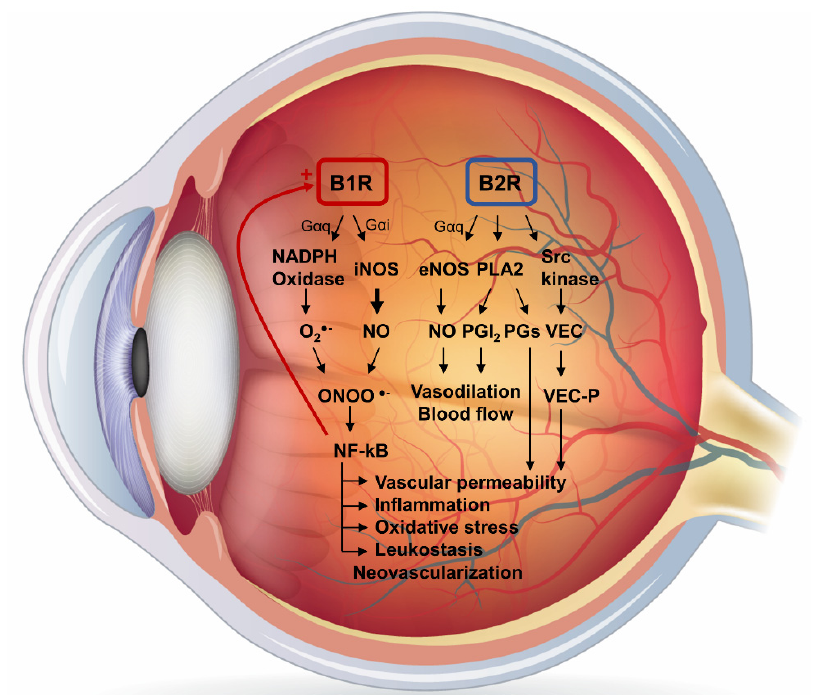
Figure 2. Kallikrein–kinin system in diabetic retinopathy. Schematic proposal of the signaling path- ways activated by B1R and B2R in diabetic retinopathy. PGs, prostaglandins; PGI2, prostacyclin; PLA2, phospholipase A2; Src, kinase proto-oncogene tyrosine-protein kinase; VEC, vascular endo- thelial cadherin; VEC-P, phosphorylated vascular endothelial cadherin. The human eye anatomy diagram was acquired from Shutterstock (http://www.shutterstock.com, accessed on 16 July 2021).